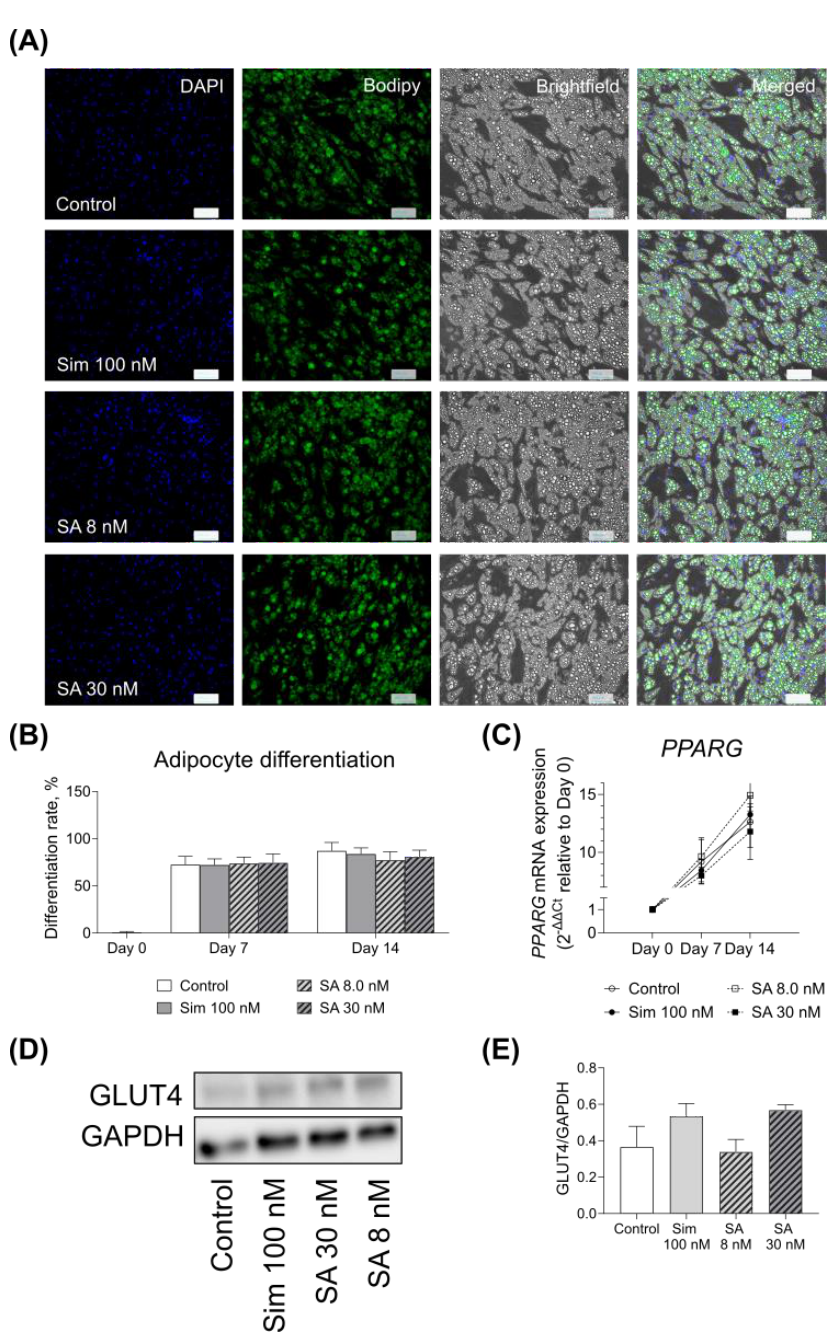
Figure 3. Effects of simvastatin and simvastatin acid on adipocyte differentiation. ( A ) Representative images of differentiation rate of adipocytes treated without (Control) or with Simvastatin 100 nM (Sim 100 nM), simvastatin hydroxy acid 8 and 30 nM (SA 8 nM and SA 30 nM, respectively). Left to right: Nuclei are shown in blue (DAPI), lipid droplets are shown in green (Bodipy), brightfield image, and merged. ( B ) Quantification of adipocyte differentiation rate. ( C ) The differentiation rate was also assessed by measuring the mRNA expression of the master regulator of adipogenesis PPARG . GUSB was used as the housekeeping gene. Relative gene expression was measured as 2 −ΔΔCt . ( D ) Representative blot of GLUT4 expression in adipocytes treated without (Control) or with Simvastatin 100 nM (Sim 100 nM), simvastatin hydroxy acid 30 nM and 8.0 nM (SA 30 nM and SA 8 nM), respectively, at day 14. ( E ) Quantification of GLUT4 expression. Graphs show mean ± S.E.M. of n = 3 independent experiments.